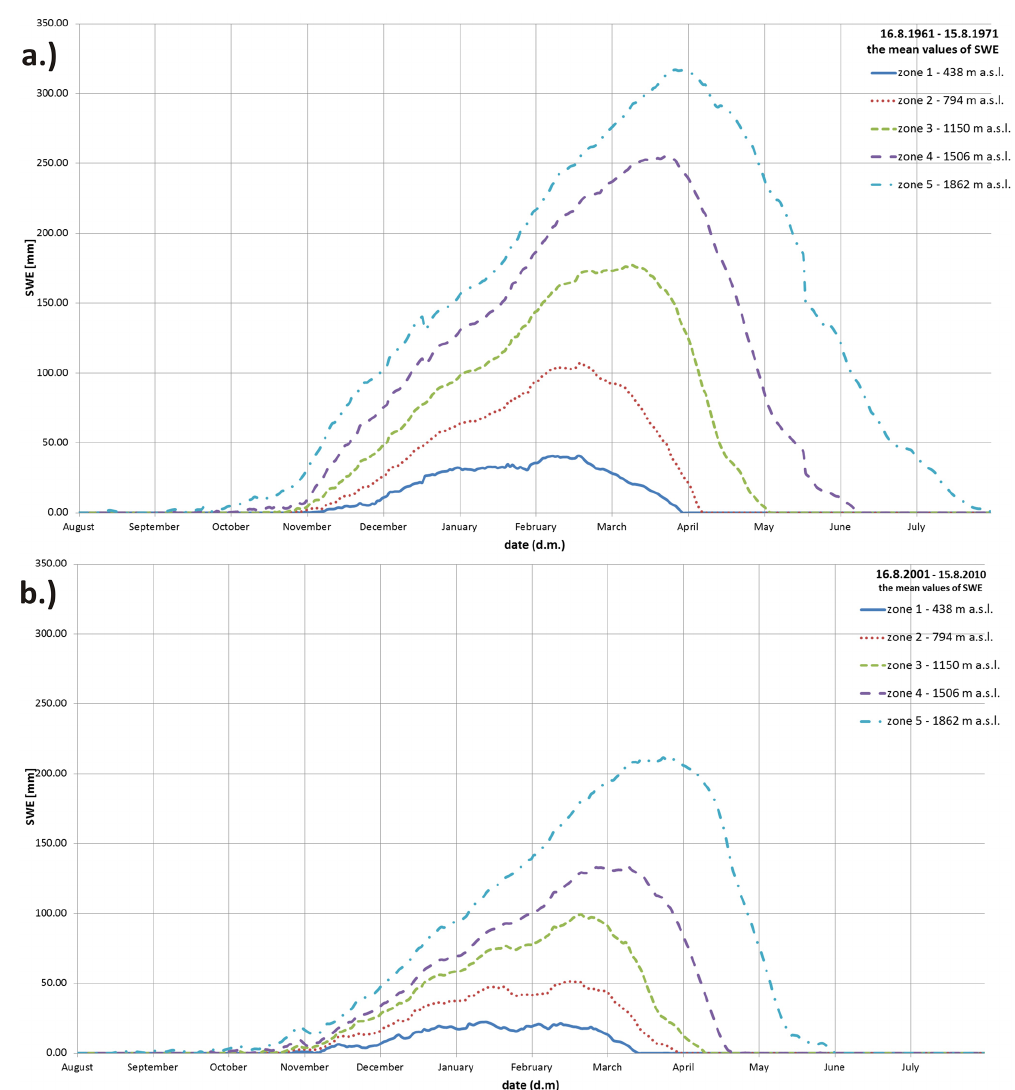
Figure 5. Simulated mean daily SWE for the decades of (a) 1961–1971 and (b) 2001–2010 in each altitude zone of the Upper Hron.